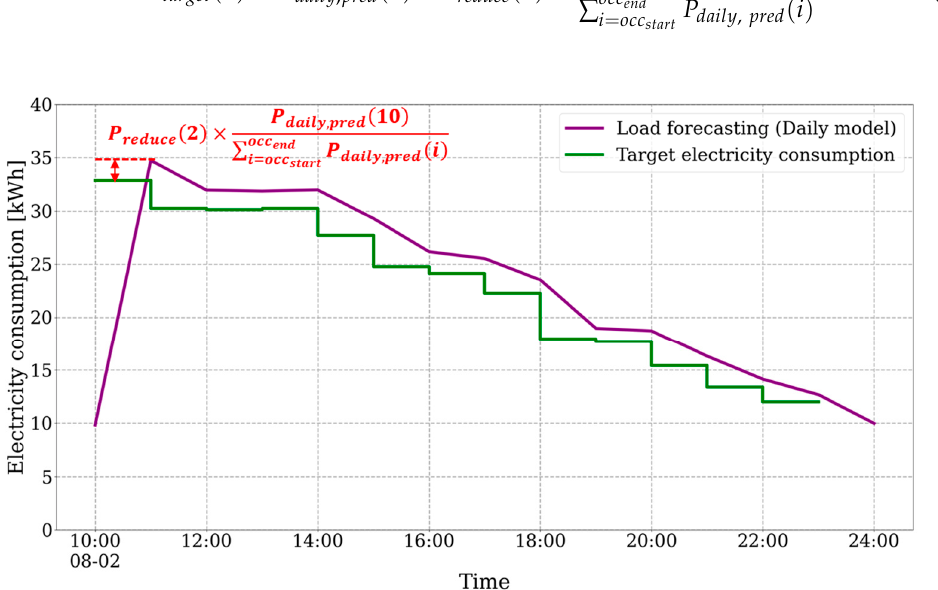
Figure 6. The target electricity